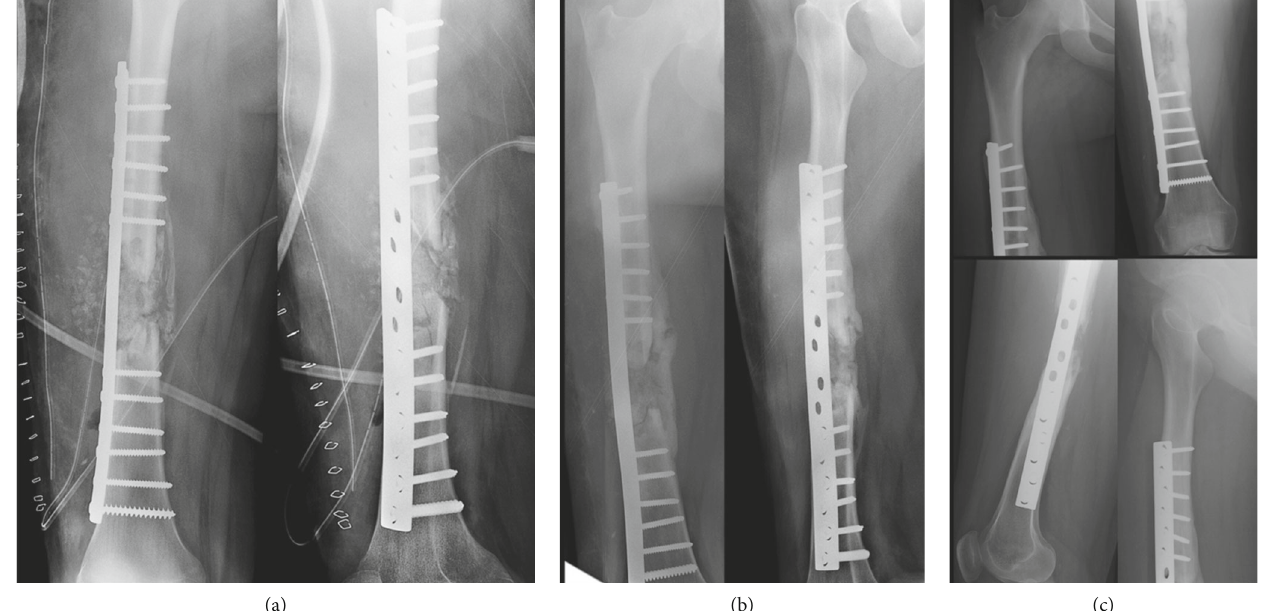
Figure 3: Second stage of the modi fi ed Masquelet technique with removal of the cement and the insertion of allograft from a bone bank (a). Succeeding follow-up views at 12 weeks (b) and 32 weeks